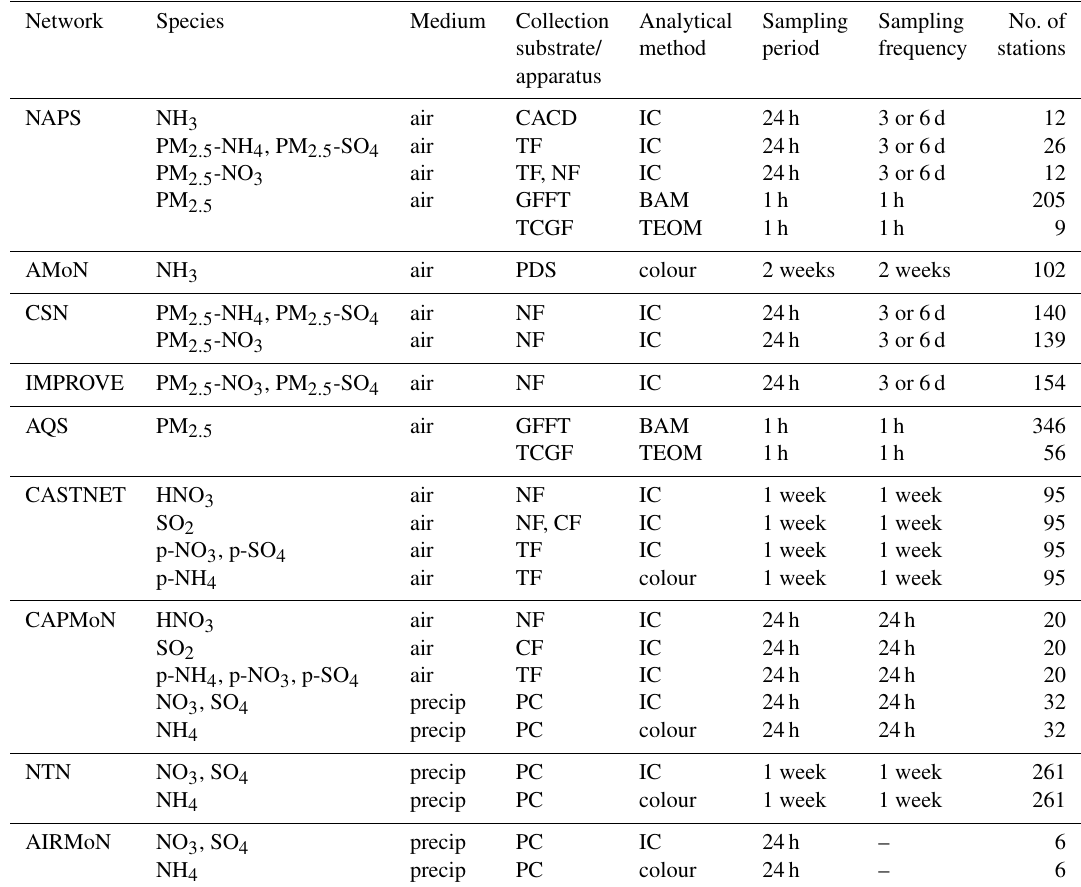
Table 1. Surface observations used in this study. Collection substrate/apparatus types include Teflon filter (TF), nylon filter (NF), K 2 CO 3 - impregnated cellulose filter (CF), Teflon-coated glass fiber filter (TCGF), glass fiber filter tape (GFFT), citric-acid-coated denuder (CACD), passive diffusion sampler (PDS), and precipitation collectors (PC). Analytical methods include ion chromatography (IC), colorimetry (colour), beta attenuation monitoring (BAM), and tapered element oscillating microbalance (TEOM). AIRMoN precipitation samples are collected within 24h of the start of a precipitation